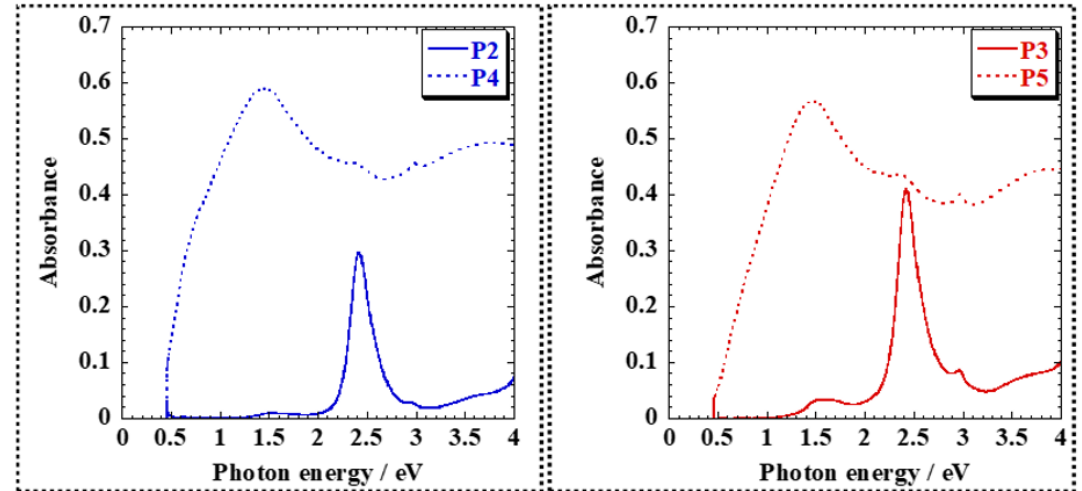
Figure 2. UV-Vis-NIR spectra of polymers ( P2 - P5 ) dissolved in phosphate buffer. [polymer] = 4.0 g/L, cell length: 0.1 mm.